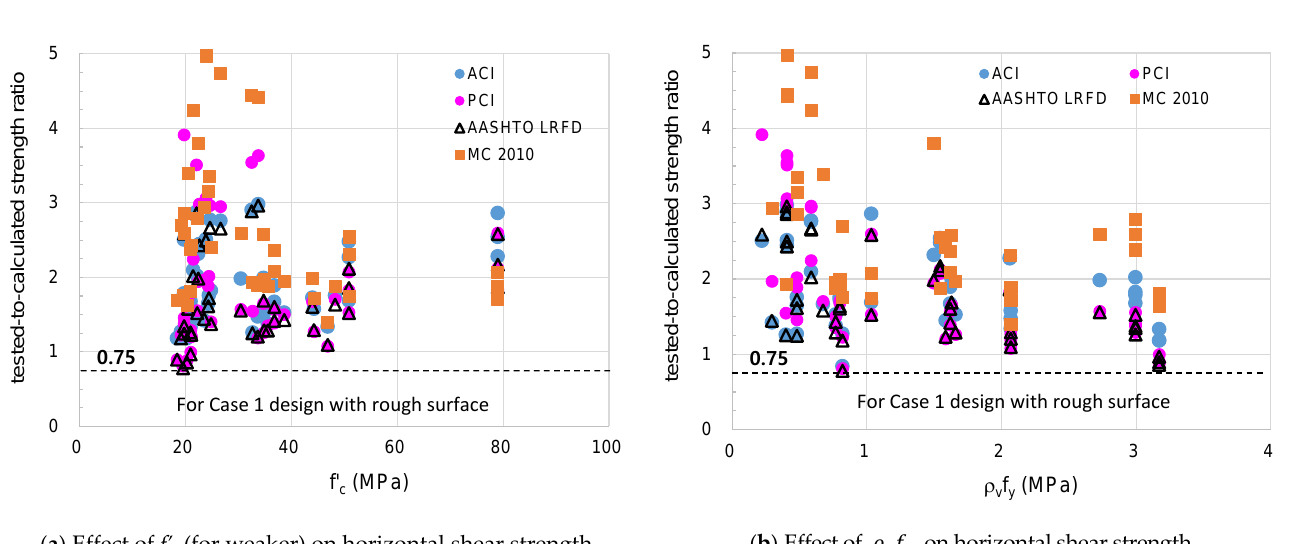
Figure 9 . Tested-to-calculated shear strength ratios for beam tests with Case 1 category (roughened surface).